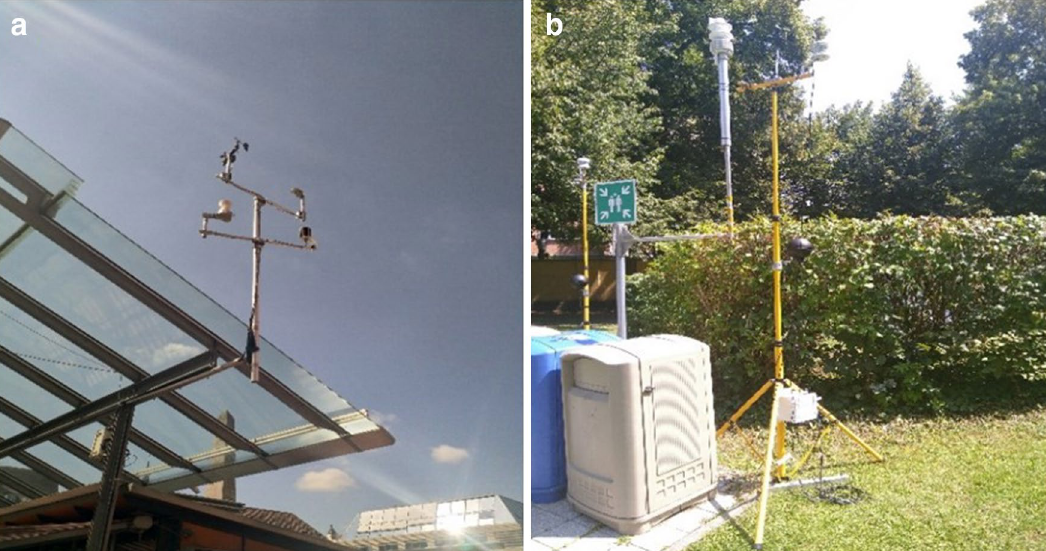
Figure 2. Meteorological station at the centre site—Marktplatz ( a ) and the mobile weather station with black globe temperature logger used to validate the WBGT calculations using the meteorological data ( b